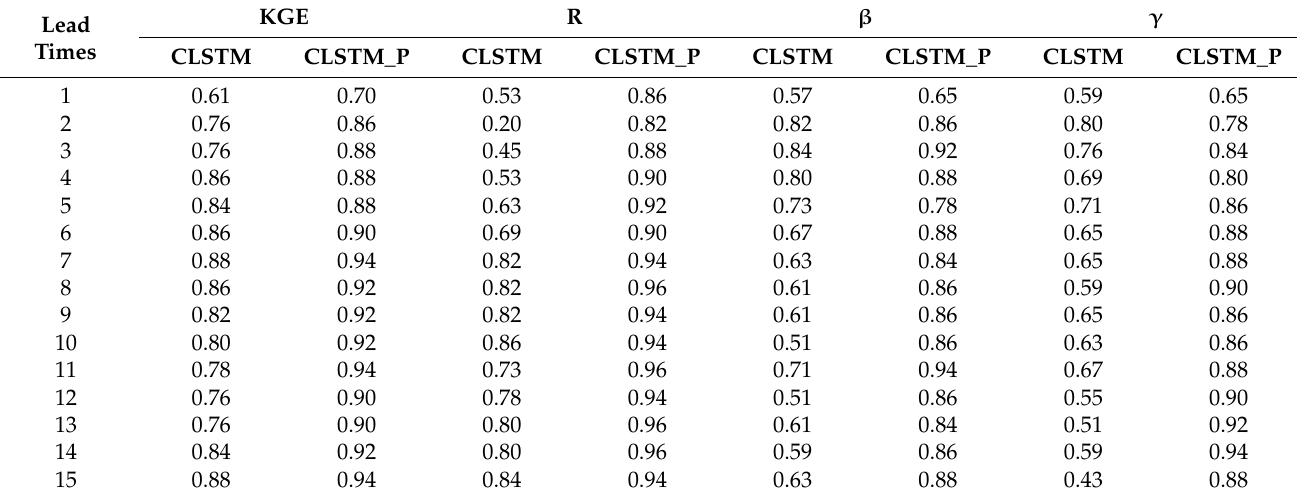
Figure 7. Spatial distributions of the KGE difference ( ∆ KGE) between the daily streamflow forecasts by the cascade LSTM model and those by the default LSTM model. Table 2. Percentage (%) of stations that improved compared to the default LSTM model, the cascaded LSTM model (CLSTM), and the cascaded LSTM with the perfect precipitation (CLSTM_P) model KGE and its three components (R, β and γ